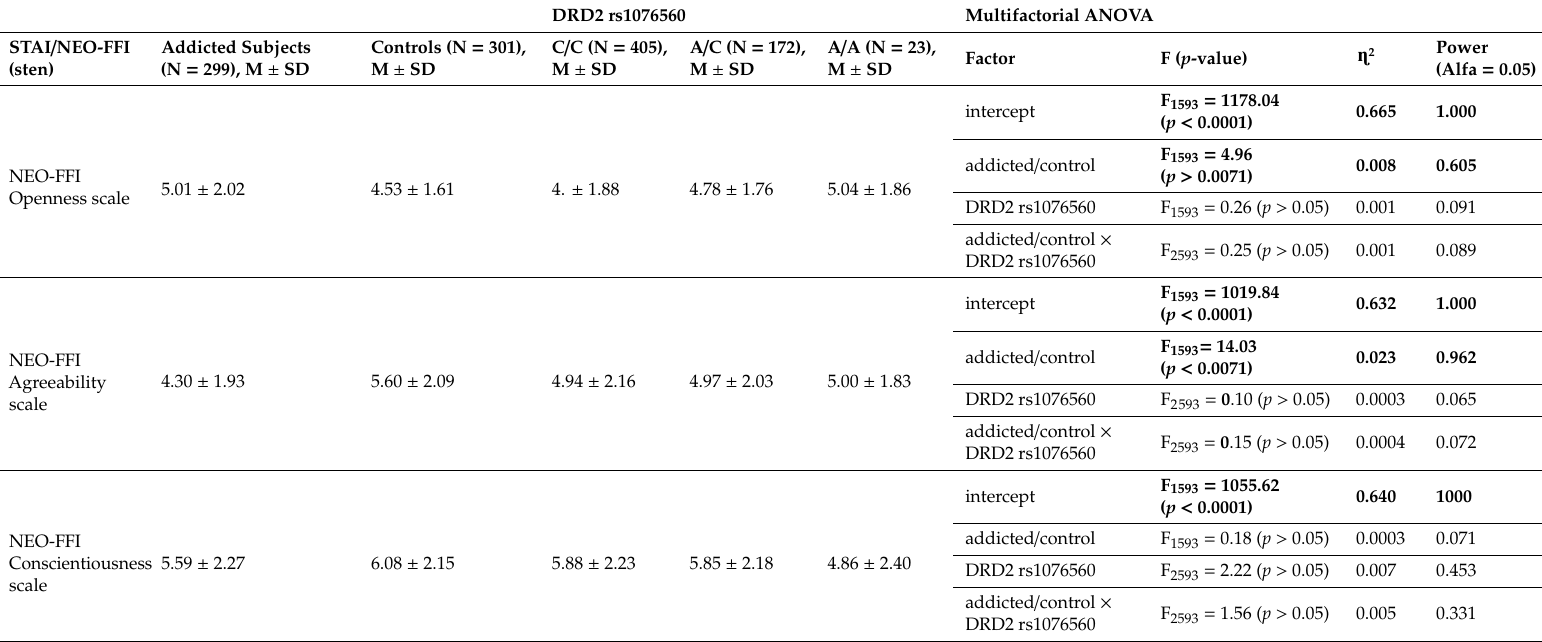
Table 4. Results of the 2×3 factorial ANOVA for the addicted subjects and the controls, incorporating the State–Trait Anxiety Inventory and the NEO Five-Factor Inventory results and DRD2 rs1076560 Table 4. Cont .